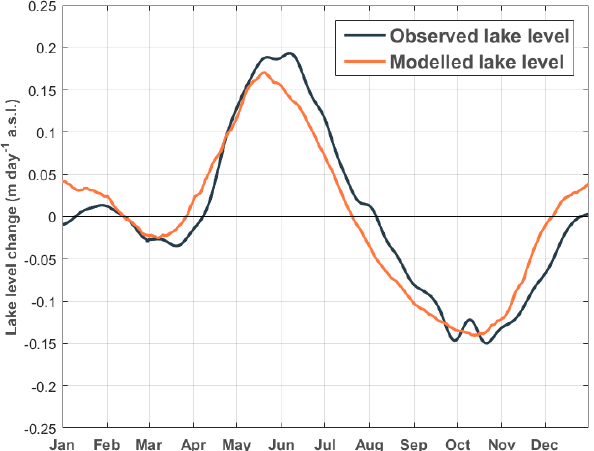
Figure 10. Seasonal cycle of the modelled and observed lake levels for the period 1993 to